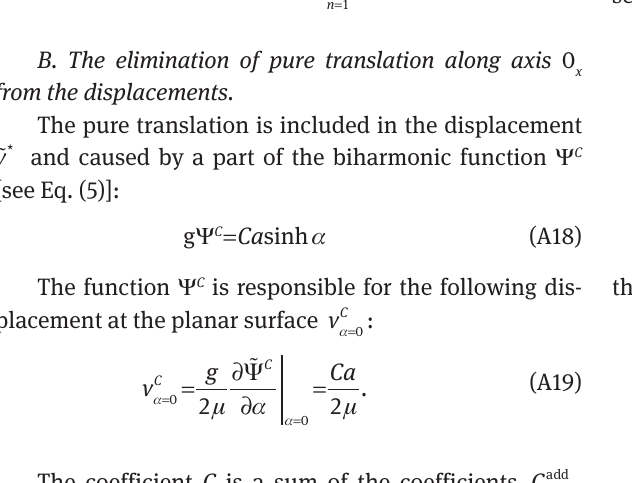
which are calculated from Eq. (A12a) for every term of the series Eq.